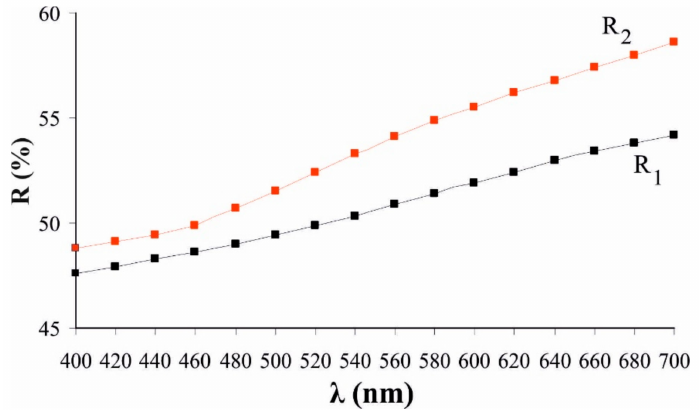
Figure 3. Reflectance data for